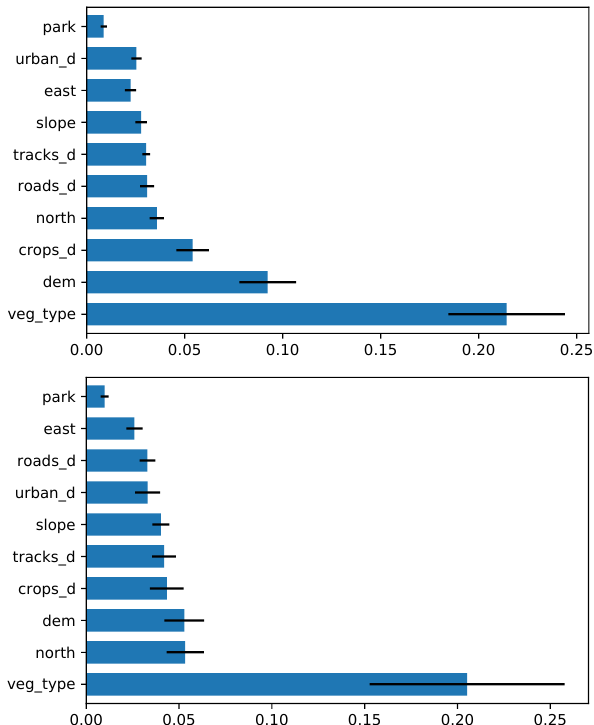
Figure 9. Variable importance rankings for RF model (global vegetation), based on the mean decrease accuracy (MDA), of the predictor variables. Summer and winter are portrayed on the top and the bottom, respectively. The blue bars represent the means of the importance score among all the folds, and black lines represent the standard